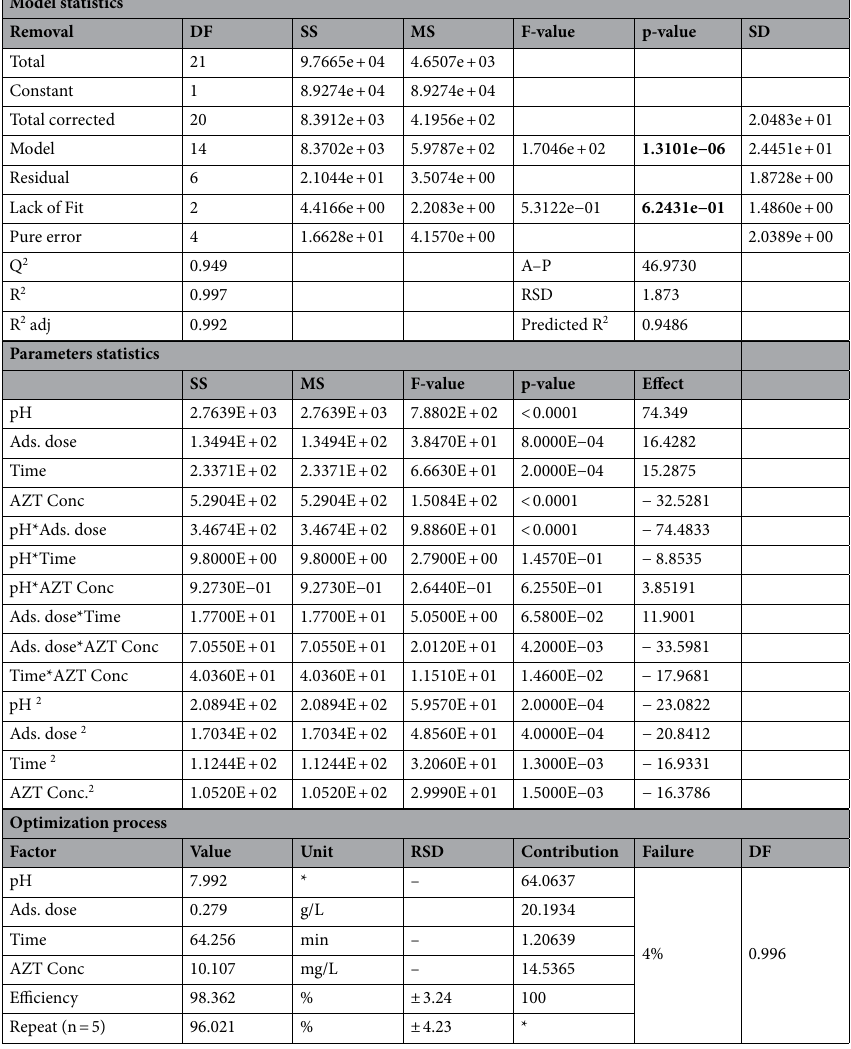
Table 2. Analysis of variance (ANOVA) for CCD modeling and process optimization